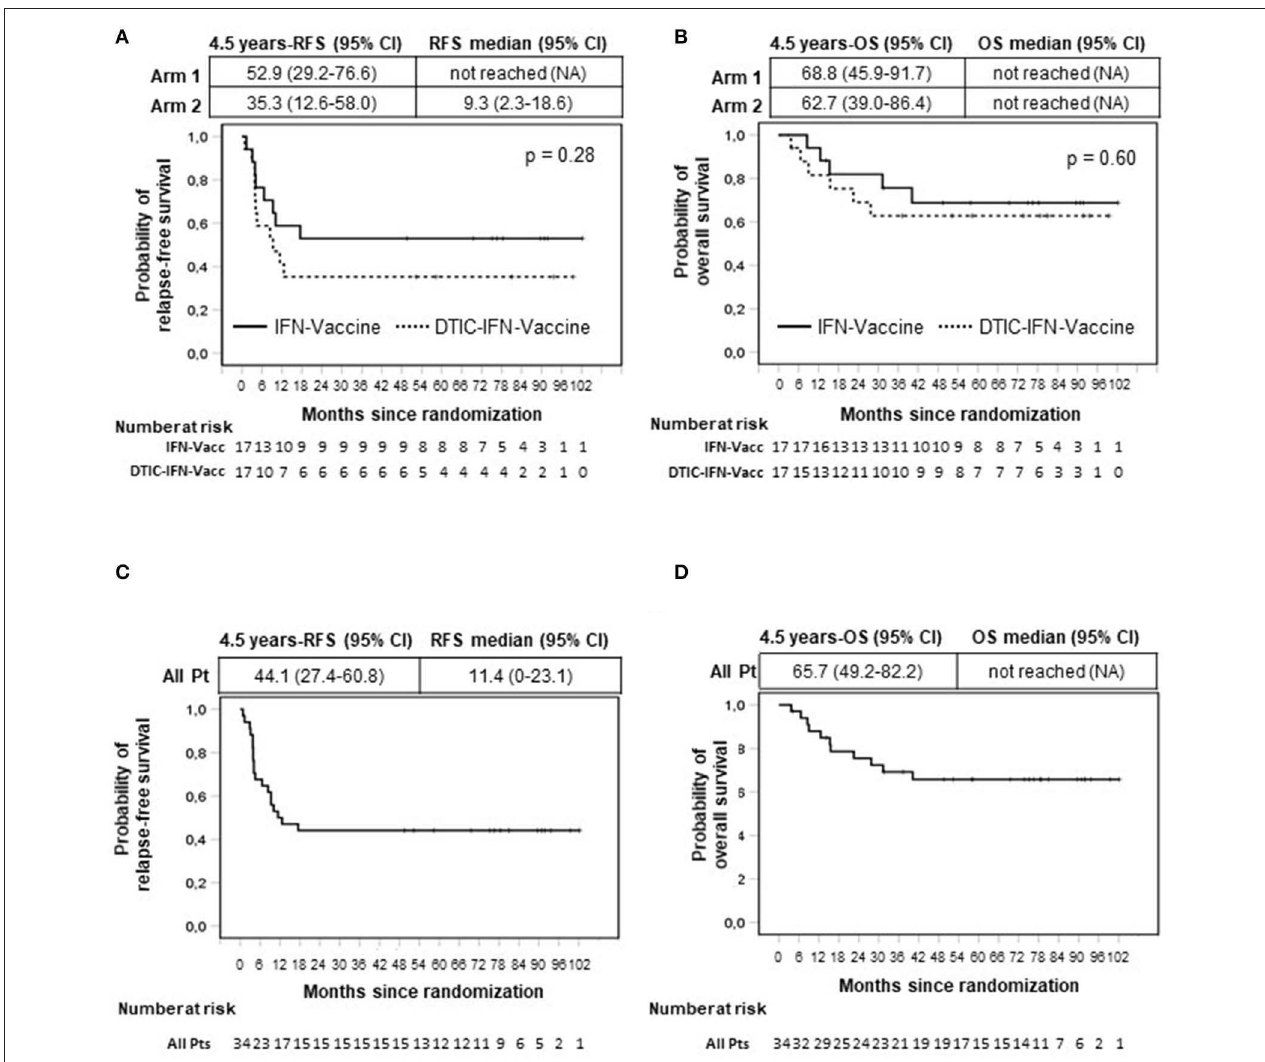
FIGURE 2 | Intention-to-treat analysis of relapse-free (RFS) (A,C) and overall survival (OS) (B,D) by Kaplan–Meier method. All enrolled patients were included in the analysis ( n = 34). Months are calculated since time of randomization. Arm 1 patients (Pt) ( n = 17) were treated with vaccination with Melan-A and NY-ESO-1 peptides (Vaccine) and interferon- α 2b (IFN). Arm 2 patients ( n = 17) received the same treatment of arm 1 patients with the addition of dacarbazine (DTIC) pretreatment. (A,B) Comparison between arms. (C,D) All patients ( n = 34). p value by log-rank